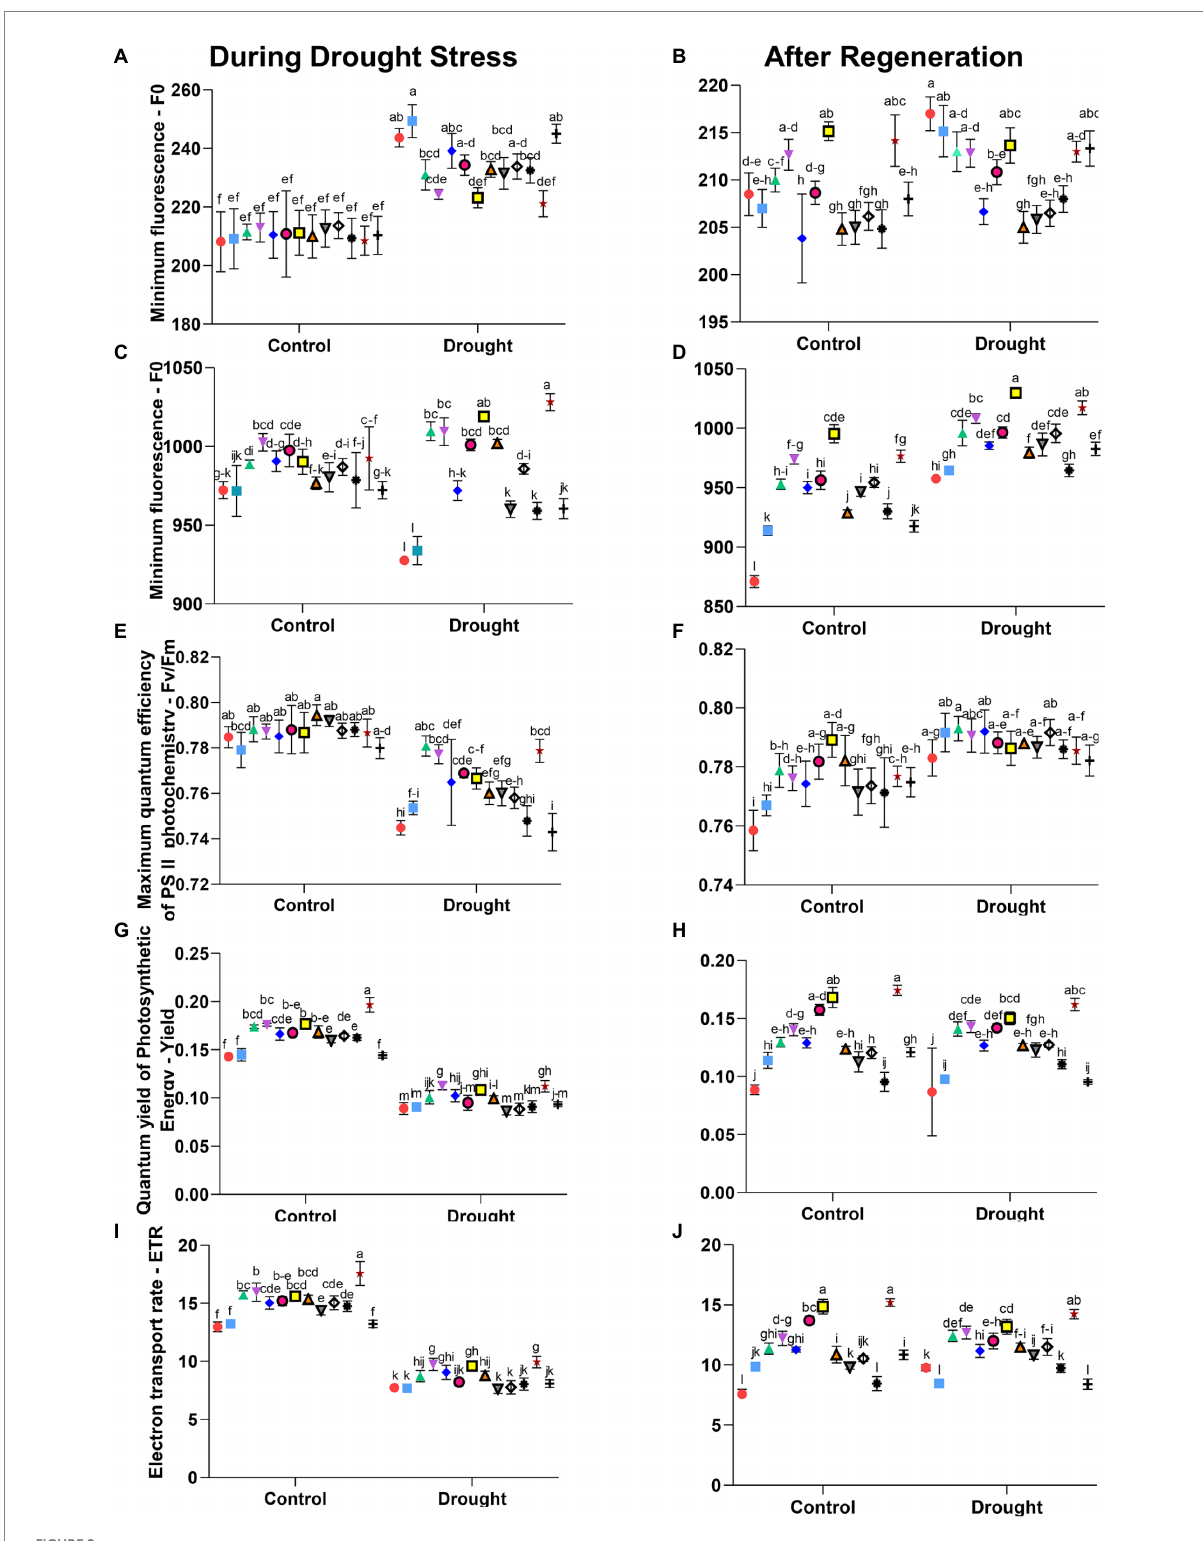
FIGURE 2 Parameters of chlorophyll fluorescence (non-nominated units): left column includes graphs with measurements during drought stress and right column the respective graphs with measurements after regeneration. Letters a-l indicate statistically different mean values ( α = 0.05) of Tukey’s HSD. The values of Least Significant Difference calculated using the same method, as well as the means over single factor (treatment or stress), their significance in One-Way ANOVA and Tukey’s HSD are presented in Supplementary Table 4. Symbols indicate active substances of seed treatments used, according to Table 1: –1, − 2, –3, − 4, −